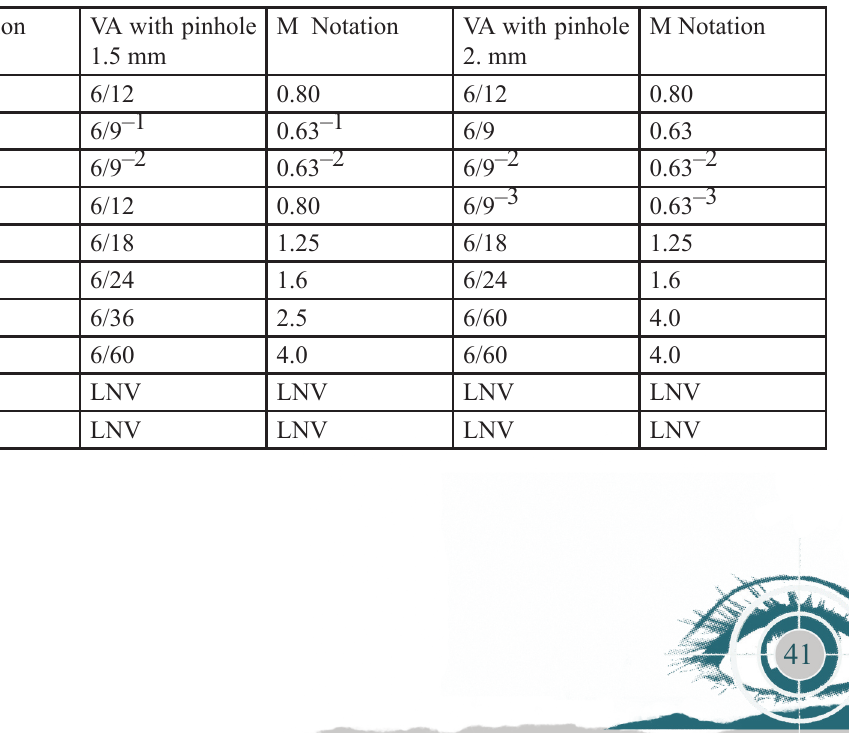
Table 5. Effect of negative lenses on VA for Subject 1 viewing a Lighthouse near acuity chart at 40 cm without a pinhole and through a pinhole with a 1.5 mm and 2 mm diameter respectively while the target was illuminated at 1